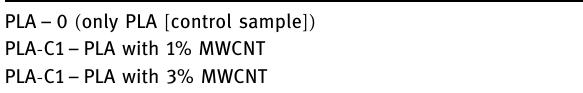
Table 2: Description of samples PLA – 0 ( only PLA [ control sample ]) PLA - C1 – PLA with 1% MWCNT PLA - C1 – PLA with 3% MWCNT